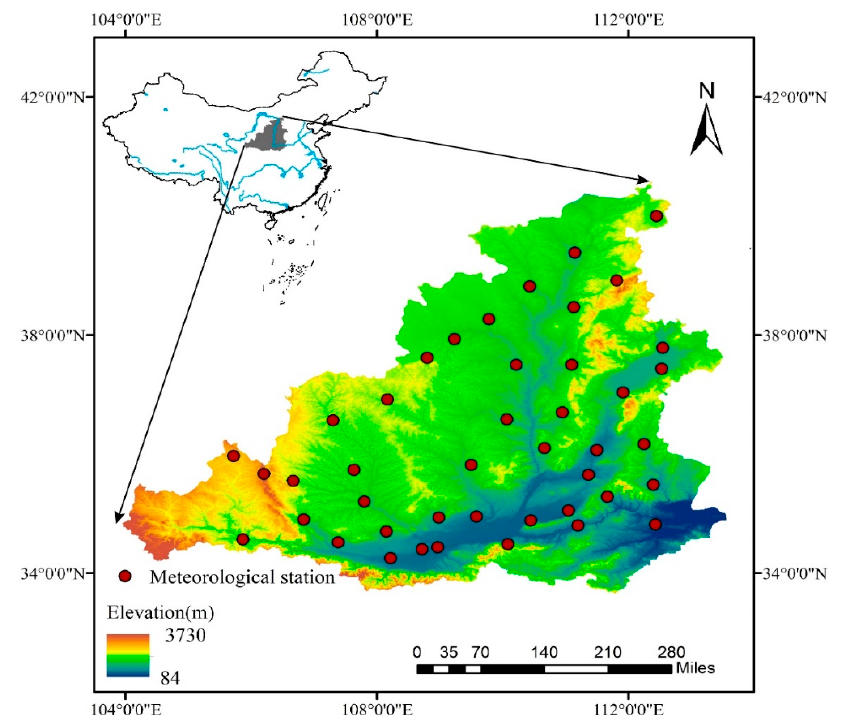
Figure 1. Location of the study area.